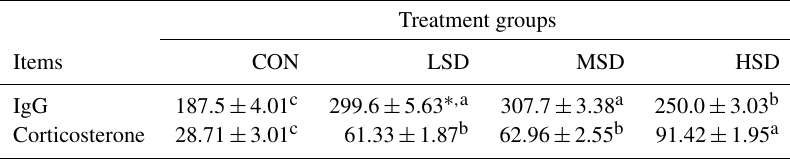
Table 5. Effect of different stocking densities on blood IgG and corticosterone levels (ngmL − 1 ) in meat ducks exposed to heat stress. Treatment groups